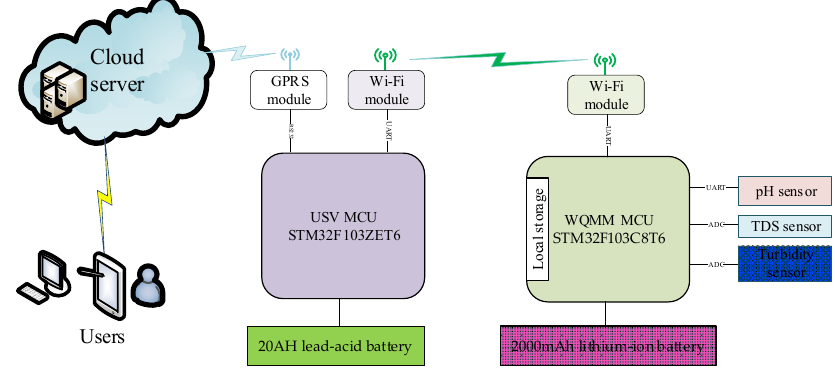
Figure 7. Diagram of the data transmission process. WQMM, w ater quality monitoring module .